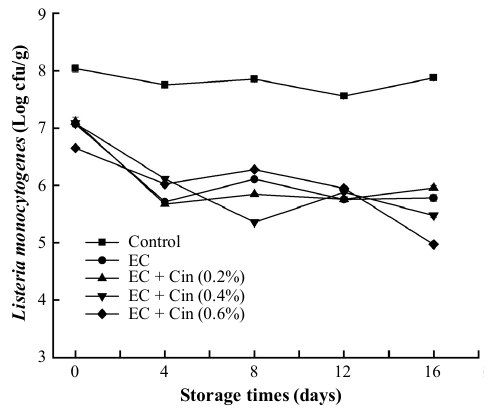
Figure 6. Reduction in Listeria monocytogenes on fresh-cut potatoes coated with chitosan-based EC containing cinnamon oil. Control: uncoated; EC: edible coating; Cin: cinnamon oil. Bars represent means ± SD ( n = 3, p < 0.05).